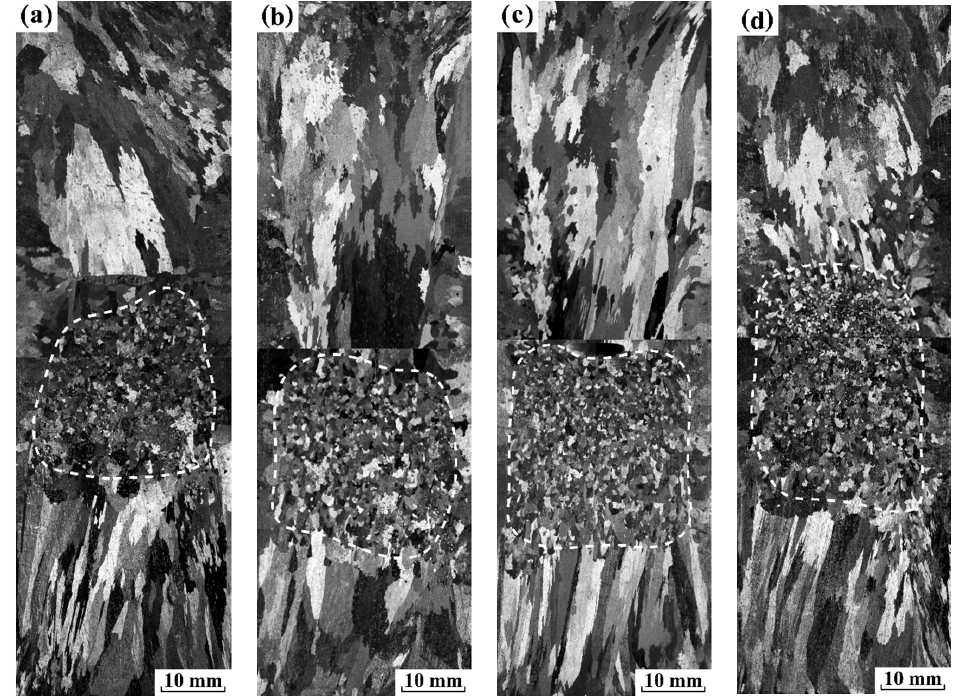
Figure 4. Longitudinal sections of the solidification structure in pure aluminum ingots under electropulsing with 900 A at di ff erent temperature of mold: ( a ) room temperature; ( b ) 373 K; ( c ) 473 K and ( d ) 573